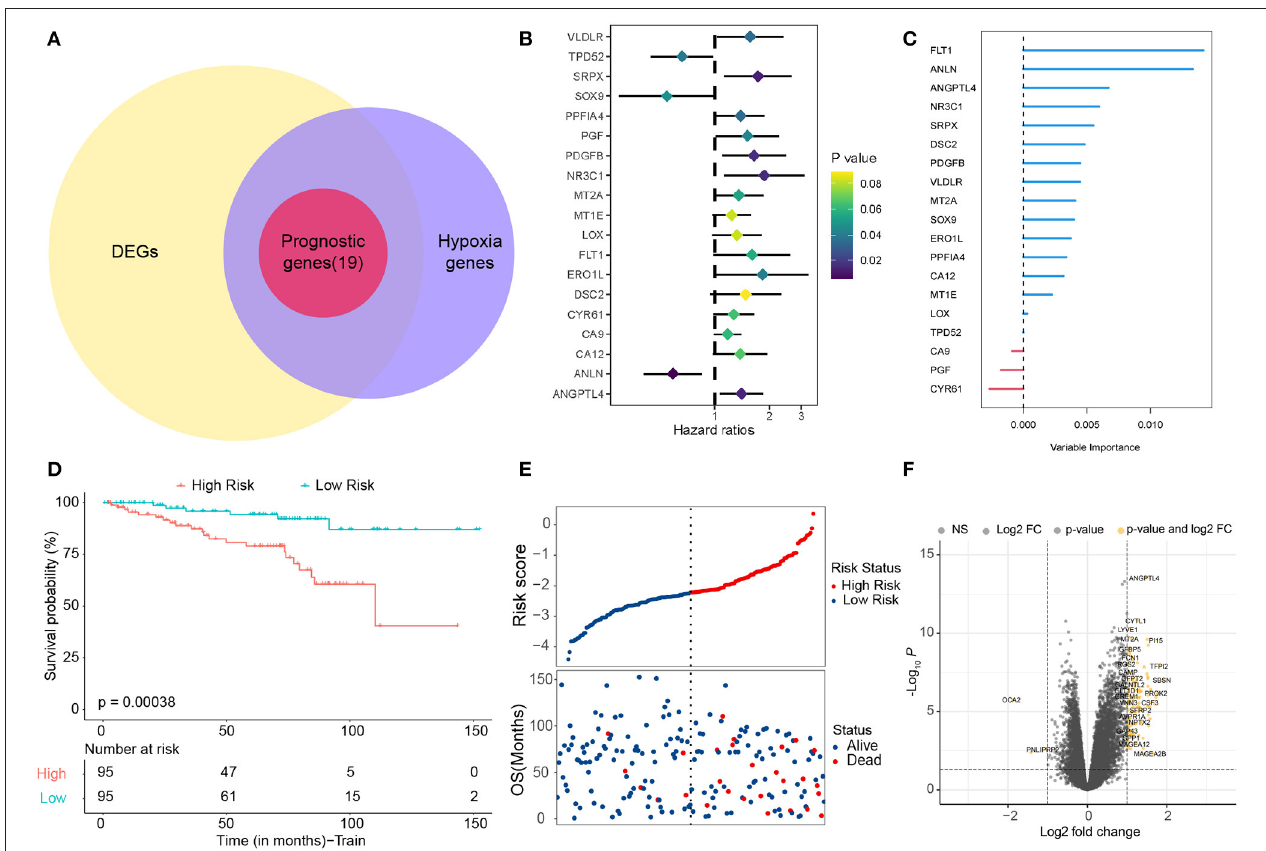
FIGURE 1 | Identification of hypoxia-related candidate genes. (A) Venn diagram to identify prognostic hypoxia-related genes. (B) Forest plots showing the results of the univariate Cox regression analysis. (C) Random survival forest analysis screened 5 genes sorted by importance. (D) Kaplan–Meier curves for the OS of patients between the high-risk and low-risk groups. (E) The distribution of the risk scores and the distributions of OS status. (F) Volcano map shows differentially expressed genes. OS, overall